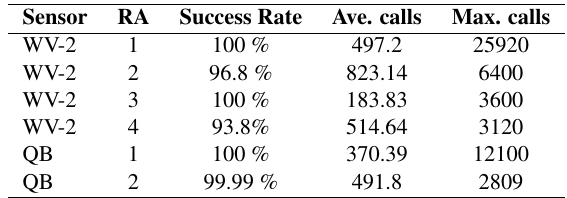
Table 3. Experimental Results, Termination of Algorithm given true Optimum